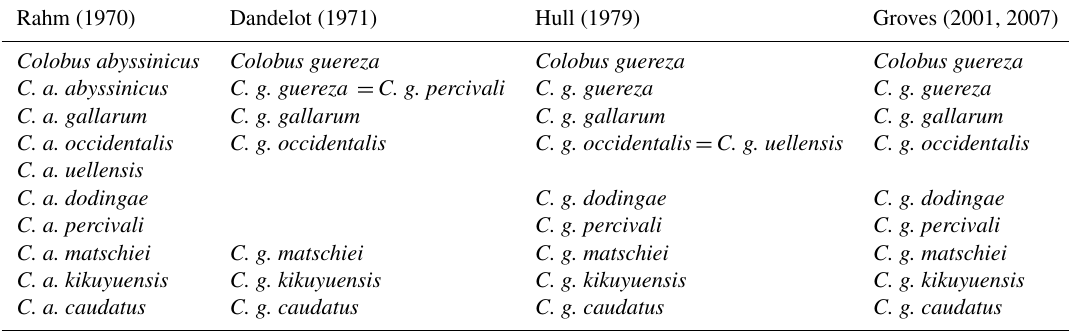
Table 1. History of the taxonomic classification of Colobus guereza .